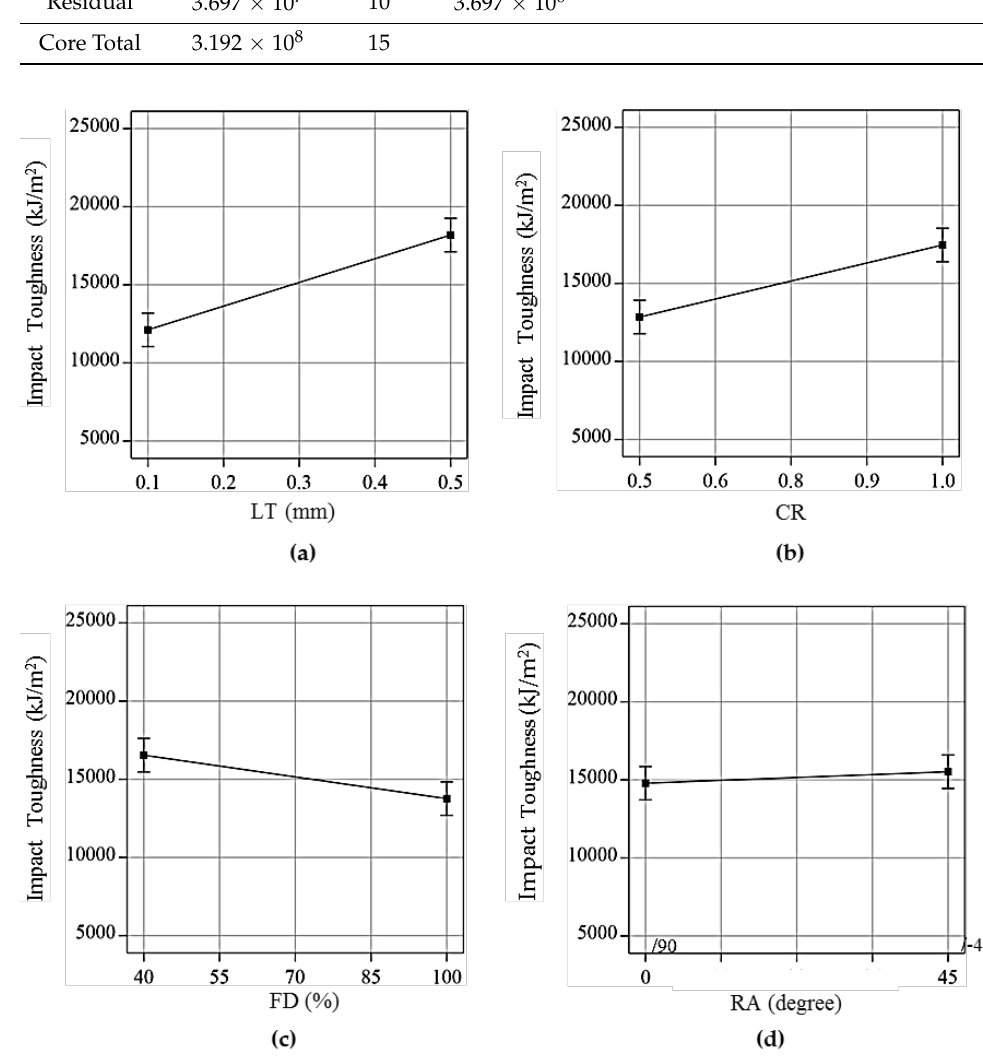
Figure 6. Effect of printing parameters on impact toughness of hybrid laminar composite: ( a ) layer thickness, ( b ) clad ratio, ( c ) fill density, and ( d ) raster angle.